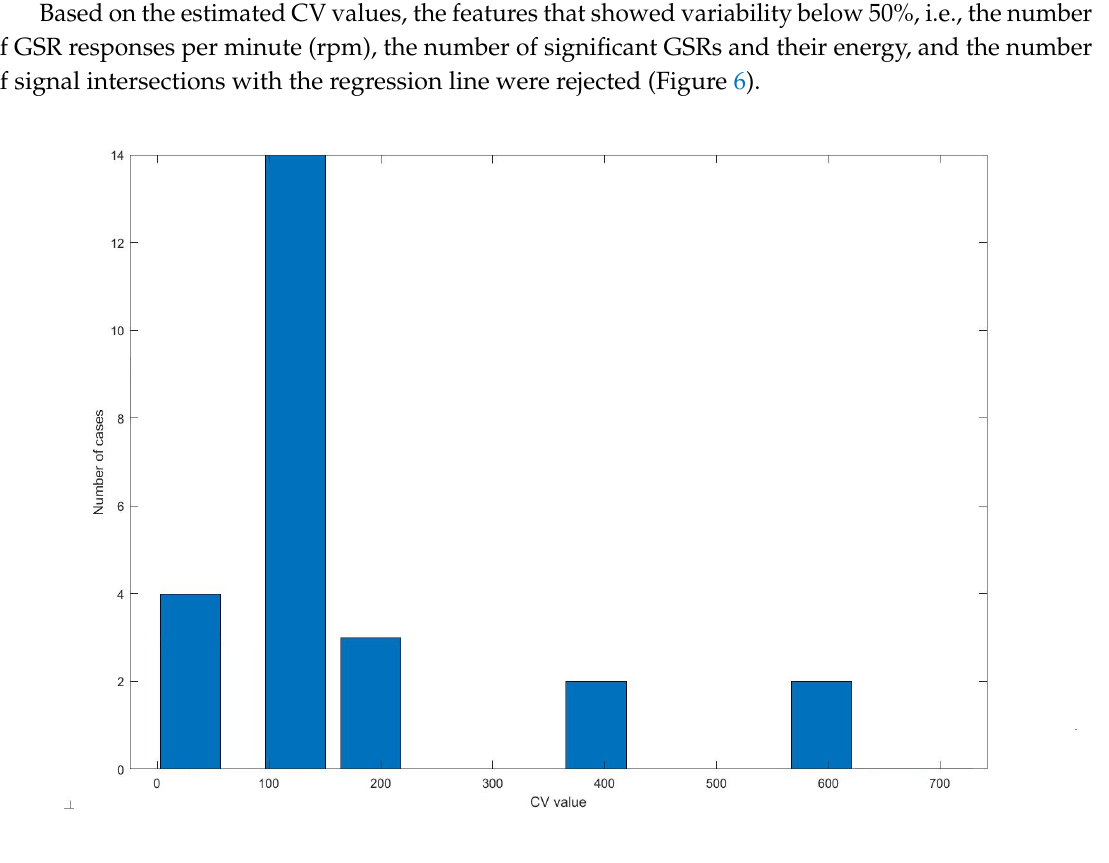
Figure 6. Histogram of coefficient of variation (CV)